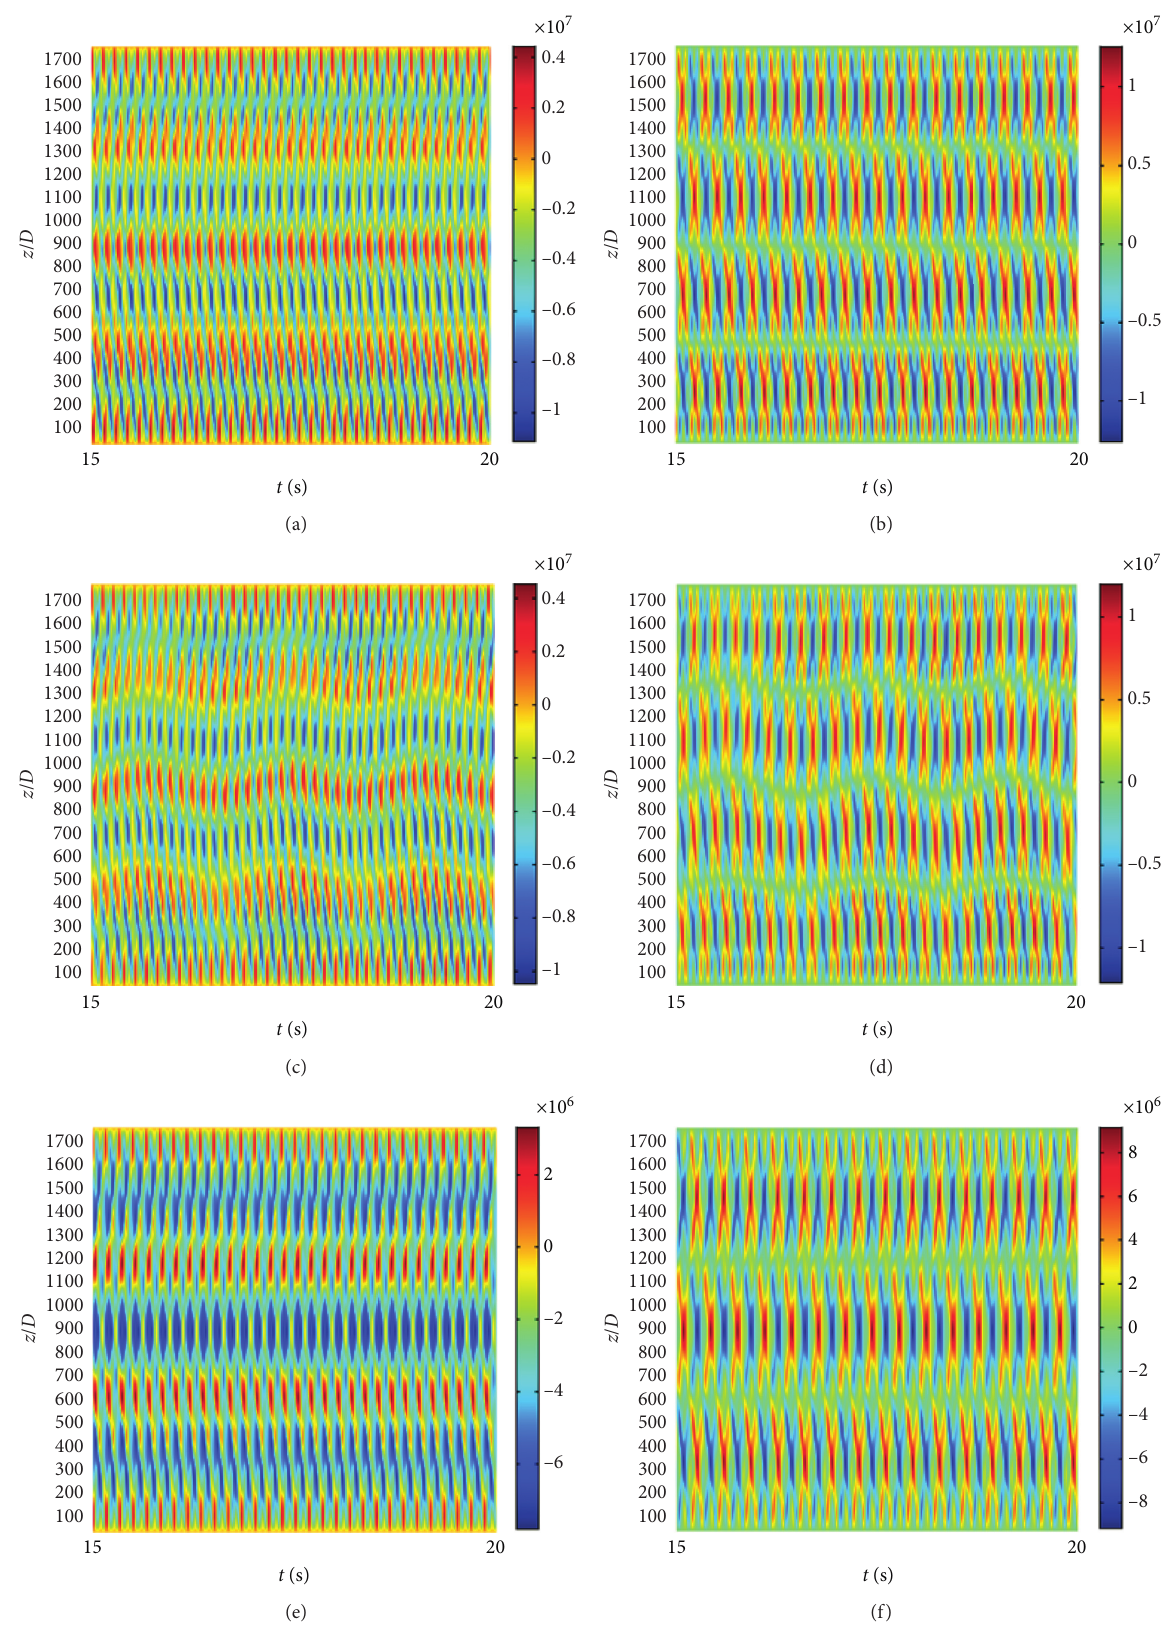
Figure 16: Space-time response of stress of the marine riser under different gas-phase volume fractions. (a) The in-line and (b) cross-flow with ε g � 0. (c) The in-line and (d) cross-flow with ε g � 0.7. (e) The in-line and (f) cross-flow with ε g �